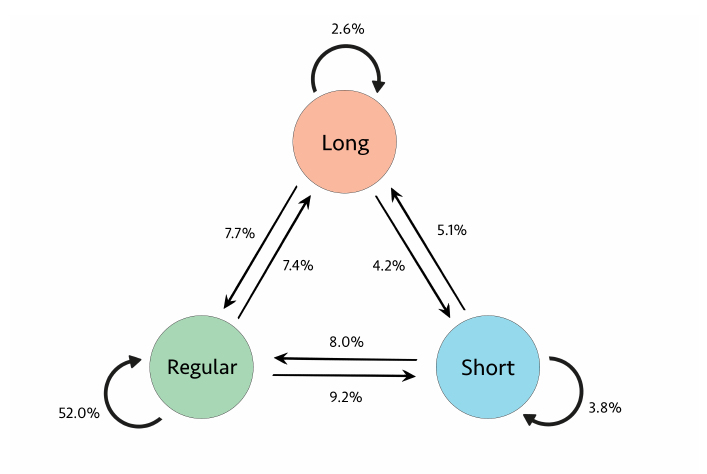
Figure 7. Transition proportions for Subject